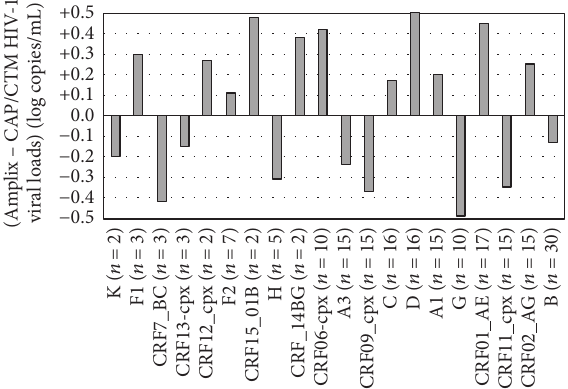
Figure 5: Mean differences (log copies/mL) of HIV-1 RNA loads measured in parallel by HIV-1 RNA-based Amplix real-time PCR assay (Biosynex) and by the reference COBAS AmpliPrep/COBAS TaqMan HIV-1 test v2.0 (Roche Molecular Diagnostics) in clinical plasma samples from 168 patients receiving antiretroviral regimen and in virological failure, representing a broad series of HIV-1 group M B subtype and non-B subtypes. Significant differences between two paired HIV-1 RNA load results were taken above 0.5 log. Table 4: Ability of the HIV-1 RNA-based Amplix real-time